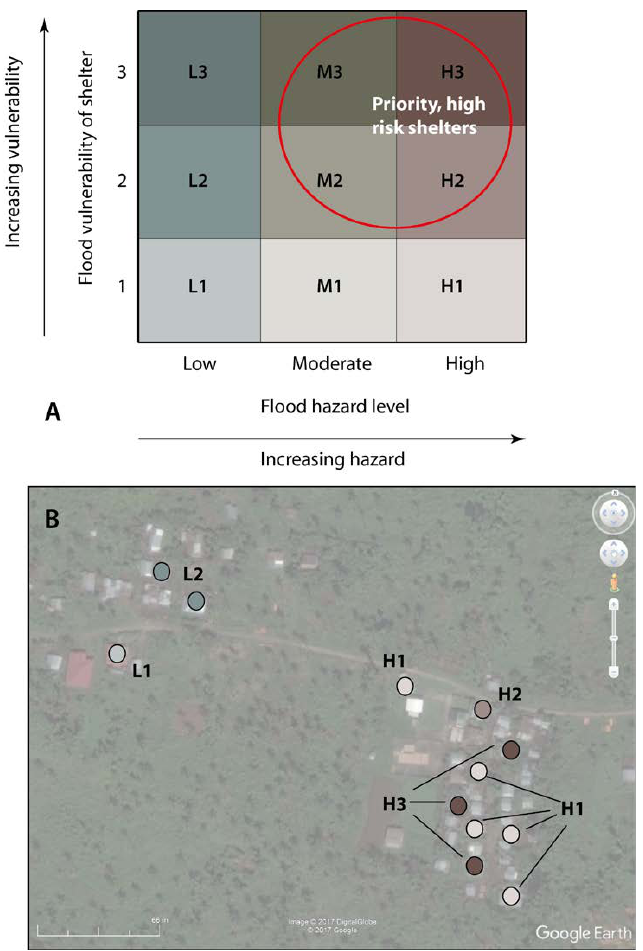
Figure 15. ( A ) Illustration of shelter risk matrix for flooding hazard. Shelters that score in the lower left corner are considered lower risk, whereas shelters that score in the upper right corner are considered high risk, priority buildings. ( B ) Using the risk matrix for flood hazard in for selected buildings in Calabnian. Base image from DigitalGlobe (11 December 2014) courtesy of Google Earth. Ongoing or future shelter assistance would be best targeted on houses scoring H3.